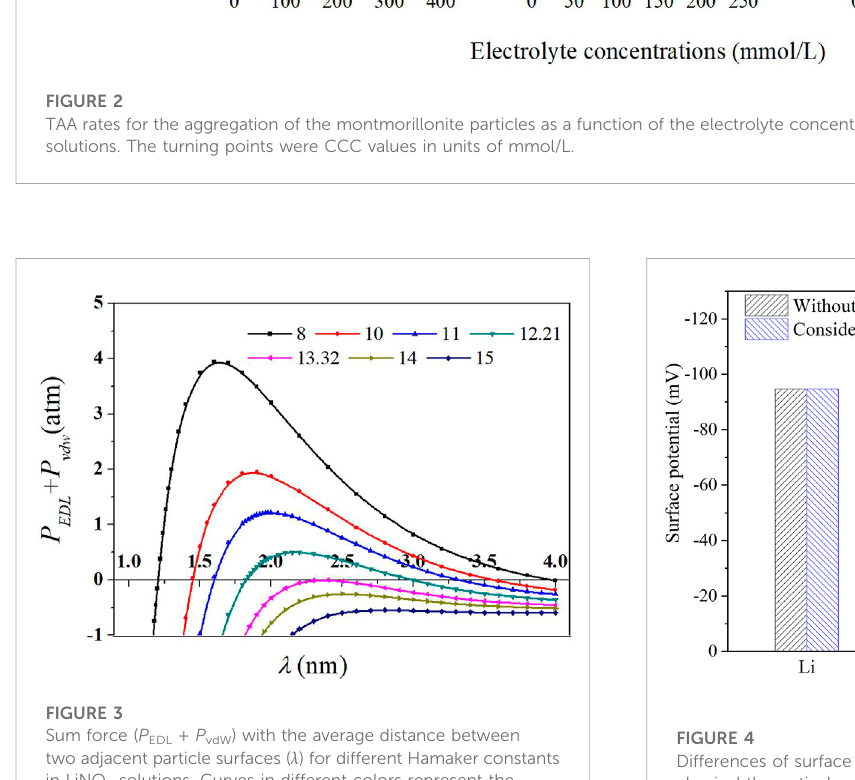
FIGURE 4 Differences of surface potential at the CCC between the classical theoretical calculation (without considering speci fi c ion effects) and the calculation considering speci fi c ion effects in LiNO 3 , NaNO 3 , and KNO 3